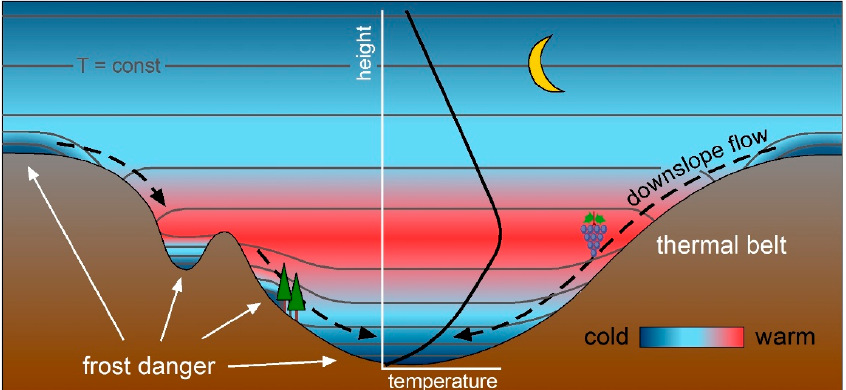
Figure 4. Illustration of airflow (dashed arrows) and air temperature distribution (isotherms and color shading) across a valley during a calm clear night. The grey lines depict the isotherms. The black solid line indicates the vertical temperature profile in the valley center. At night, the coldest air (indicated in blue) is typically found at lowest elevations in basins and valleys, in small topographic depressions along slopes, and in small areas upslope of dense vegetation. The upper slopes and ridge tops that are unaffected by cold air pooling can also be subject to frost. At the top of the temperature inversion, air is warmest (indicated in red). The thermal belt is the area on the slope around the height of temperature inversion top where it is relatively warm compared to the lower slopes and upper slopes. The thermal belt affects the growing season and agricultural management practices and provides ideal locations, for example, for